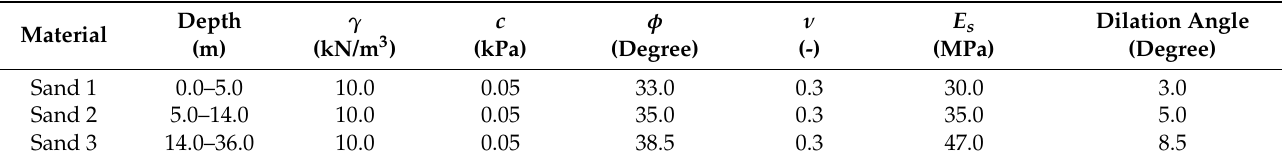
Table 3. Material properties of soil layers [38].